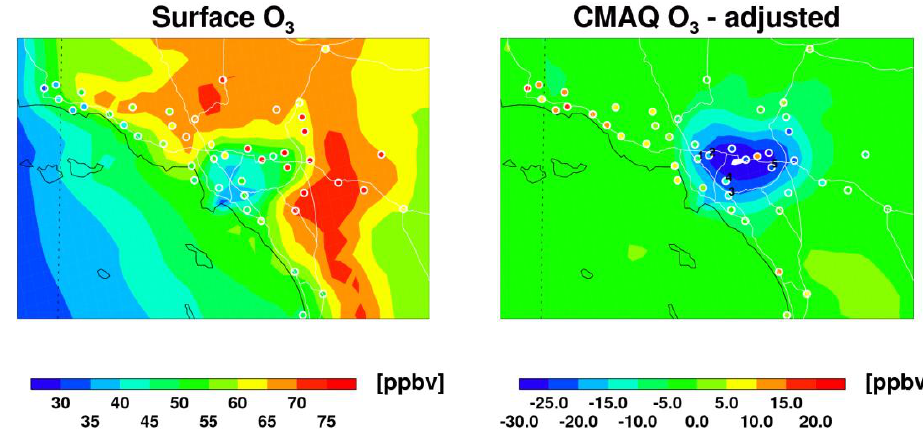
Fig. 4. Surface O 3 concentrations from the baseline CMAQ with baseline emissions, BASE2009 (left panel), and EPA AQS measurements (circles on the left panel), the difference between the surface O 3 of the baseline CMAQ with BASE2009 and CMAQ with GOME-2-adjusted NO x emissions GOME2009 (right panel) and the difference between the surface O 3 of the baseline CMAQ with BASE2009 and EPA AQS (circles on the right panel, baseline CMAQ simulations – EPA AQS observations) for the daytime (13:00–17:00LT) in August 2009.